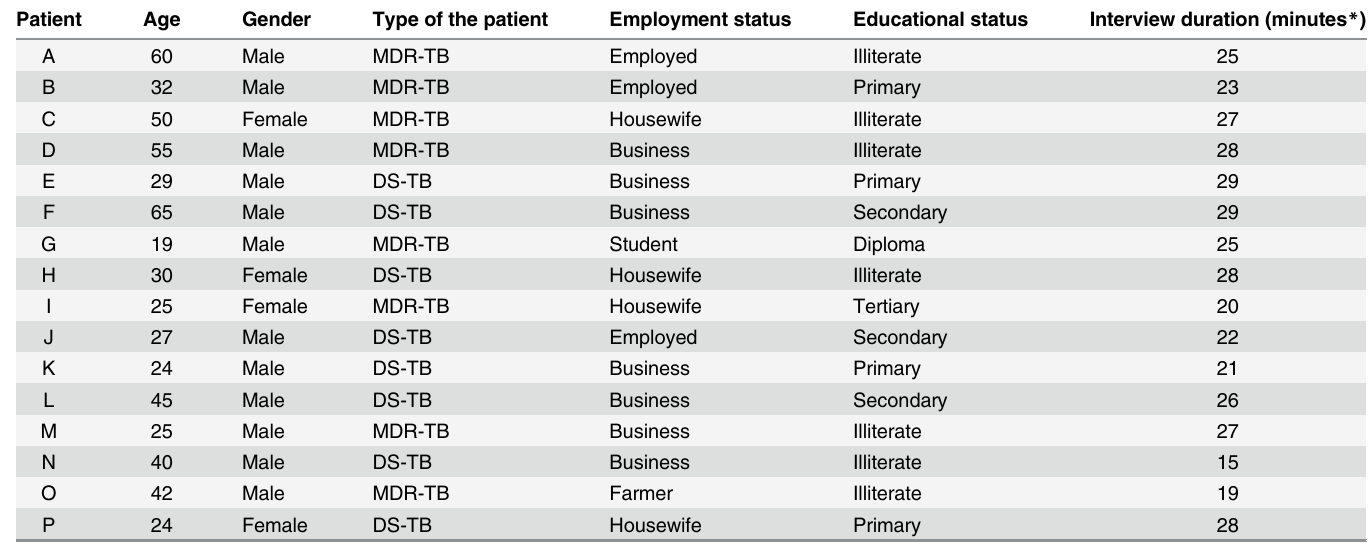
Table 1. Characteristics of the